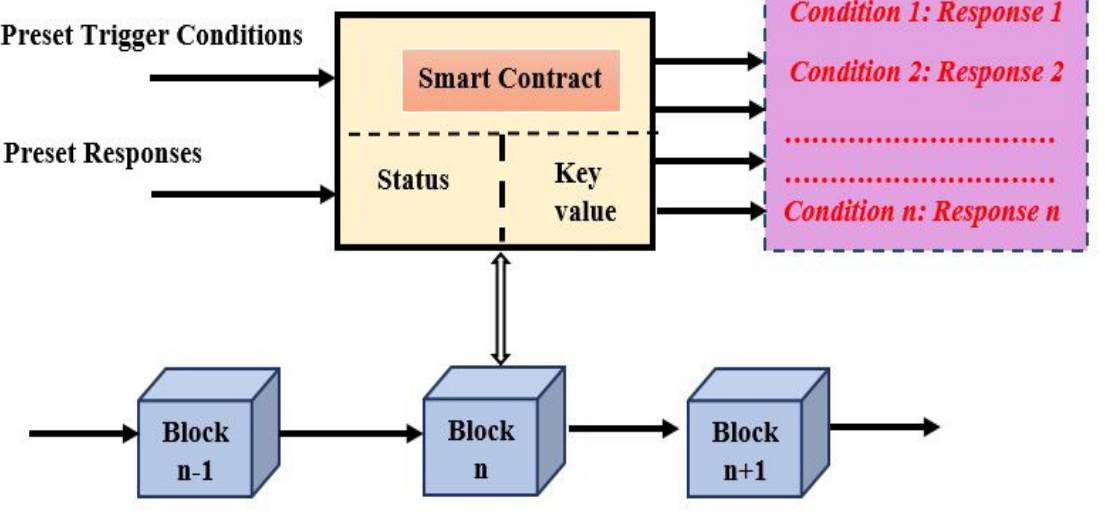
Figure 2. Basic structure of smart contract.